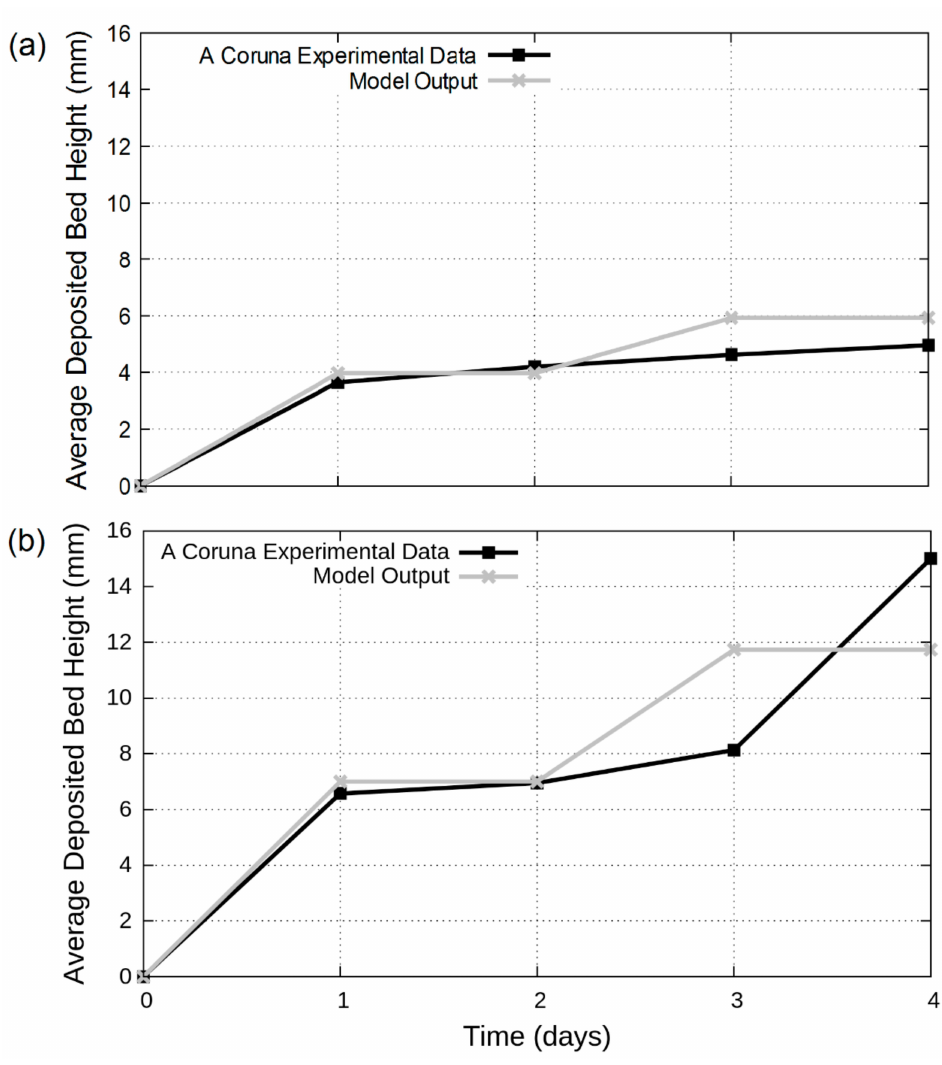
Figure 5. Measured average deposited bed heights from the A Coruña pilot sewer compared to the modelled SSF average deposited bed height for ( a ) Scenario 6 and ( b ) Scenario 7. Please note that the modelled deposited heights have been averaged for the entire length of the sewer channel besides the last 0.2 m in which the change in bed height was